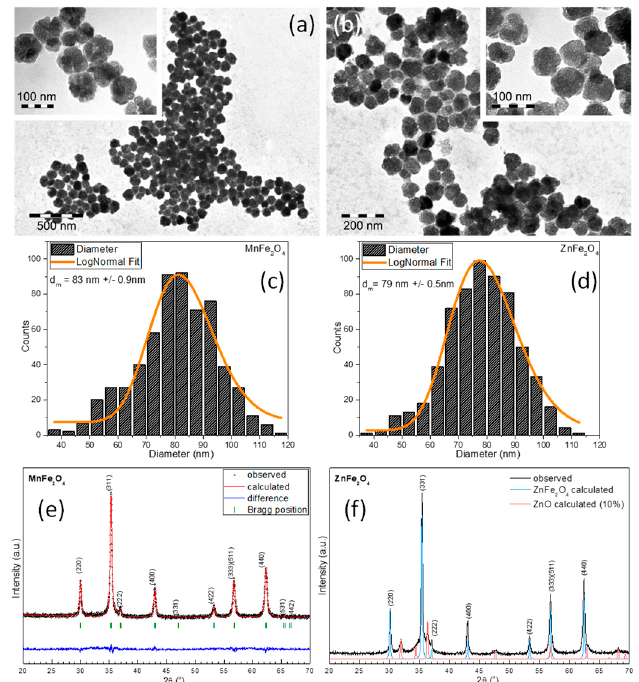
Figure 1. Large-scale TEM images of ( a ) MnFe 2 O 4 magnetic nanoparticles (MNPs) and ( b ) ZnFe 2 O 4 MNPs synthesized in ethylene glycol (EG). Insets are zoomed-in large-scale TEM images. Size distribution histograms of ( c ) MnFe 2 O 4 MNPs and ( d ) ZnFe 2 O 4 MNPs fitted to a log-normal distribution (orange lines) and their corresponding XRD diffraction patterns ( e , f ).